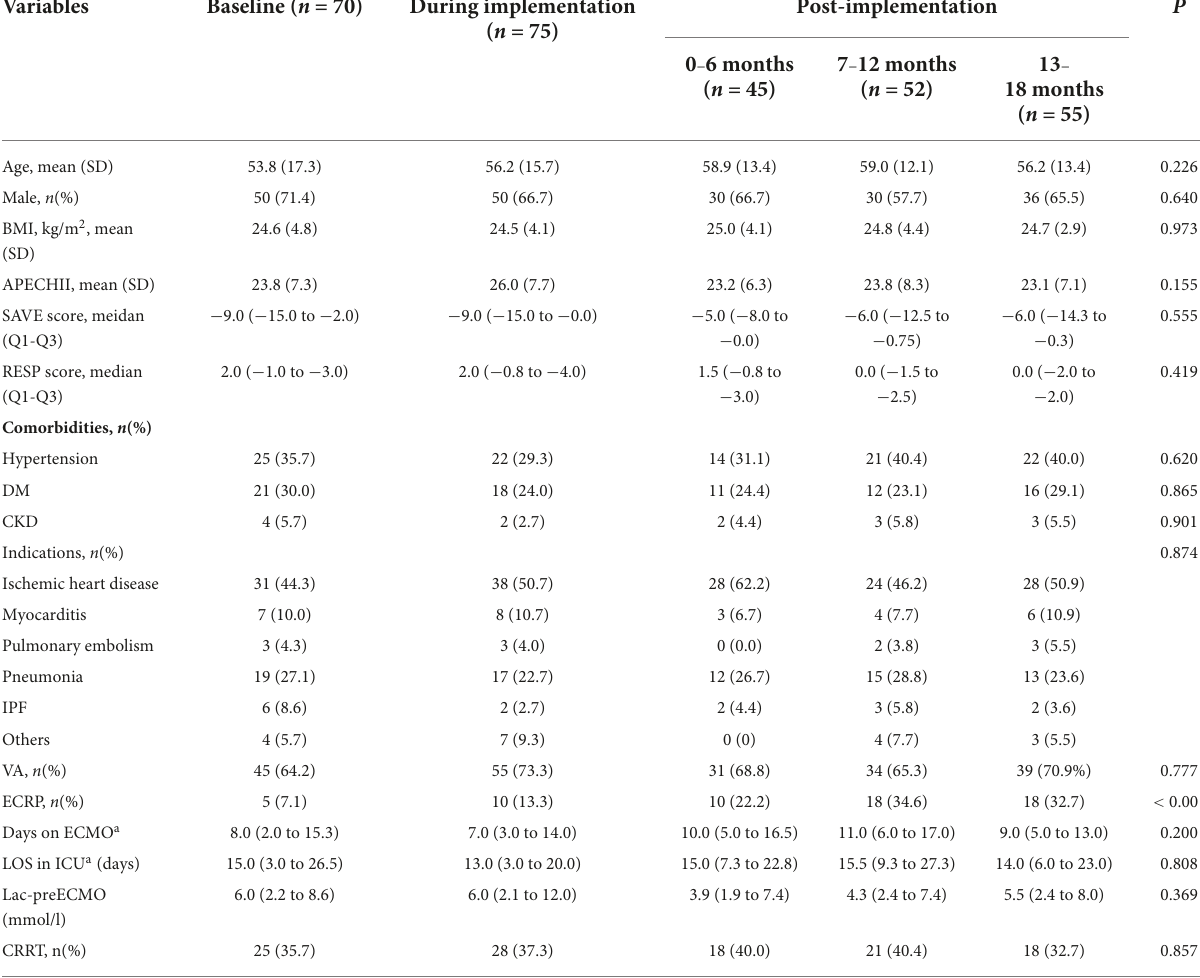
TABLE 1 Baseline characteristics of the patients with extracorporeal membrane oxygenation (ECMO).